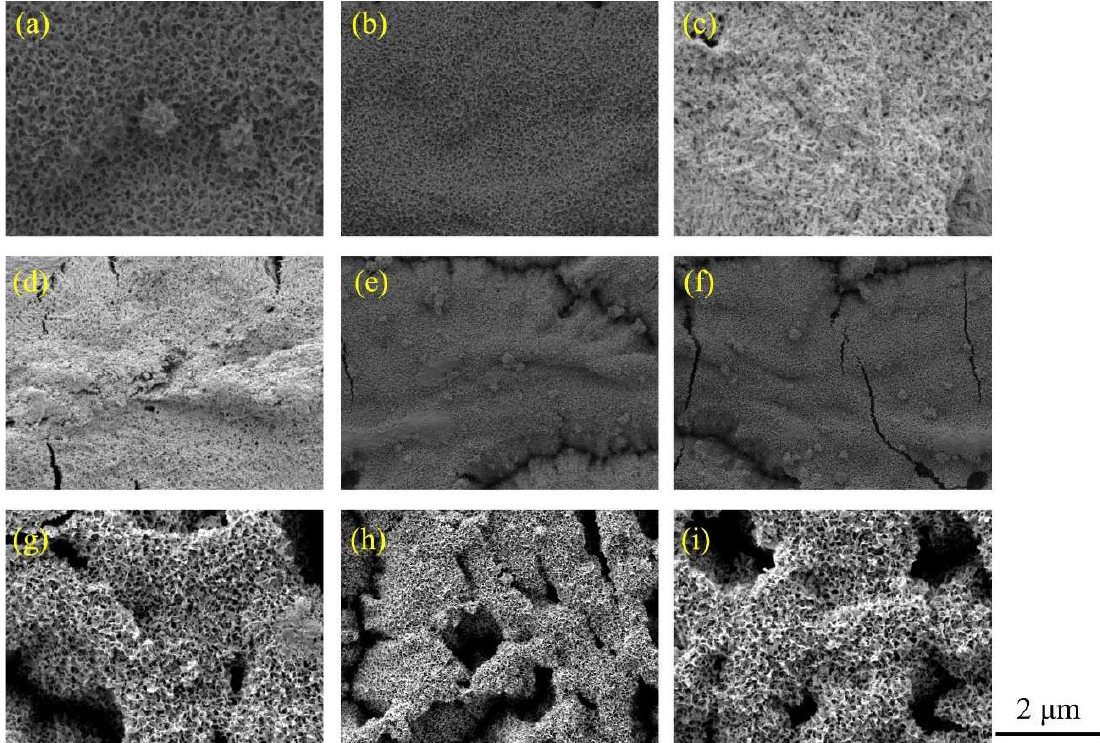
Figure 9. Micro surface photograph of the Cu 2 O/Al 2 O 3 coating after being reused ( a ) once, ( b ) twice, ( c ) 3 times, ( d ) 4 times, ( e ) 5 times, ( f ) 6 times, ( g ) 7 times, ( h ) 8 times and ( i ) 9 times.